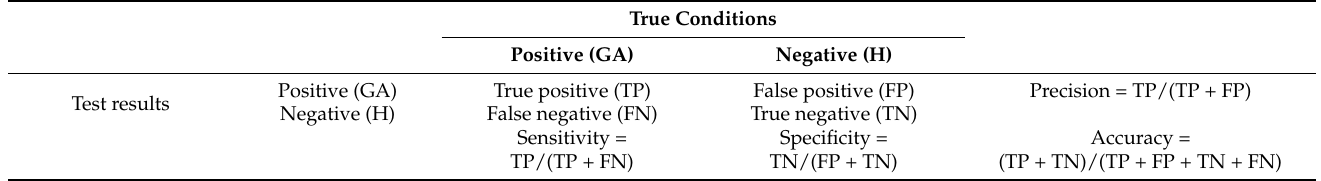
Table 2. The calculation formula of four metrics.